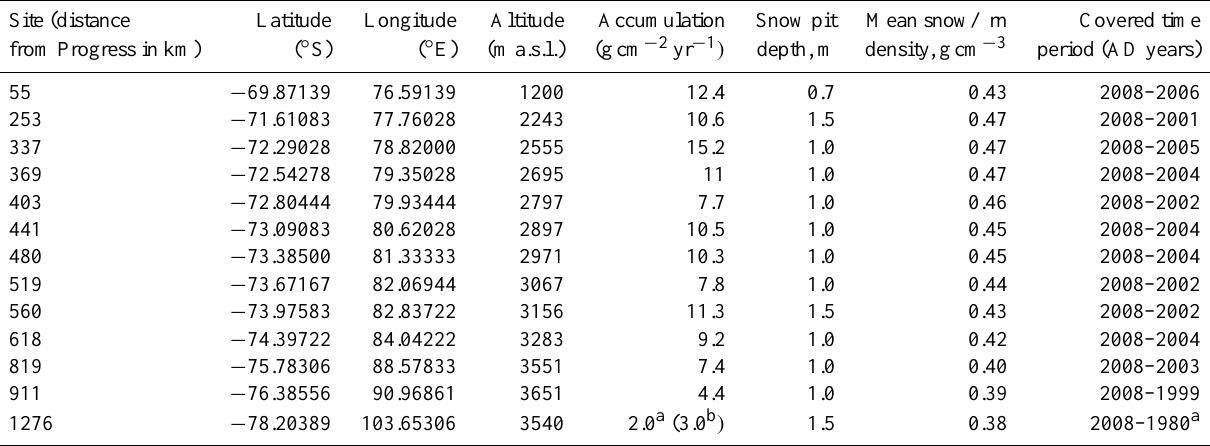
Table 1. Description of sampling sites along the Progress–Vostok traverse, East Antarctica, January of 2008. Site (distance Latitude Longitude Altitude Accumulation Snow pit Mean snow/firn Covered time from Progress in km) ( ◦ S) ( ◦ E) (ma.s.l.) (gcm − 2 yr − 1 ) depth, m density, gcm − 3 period (AD